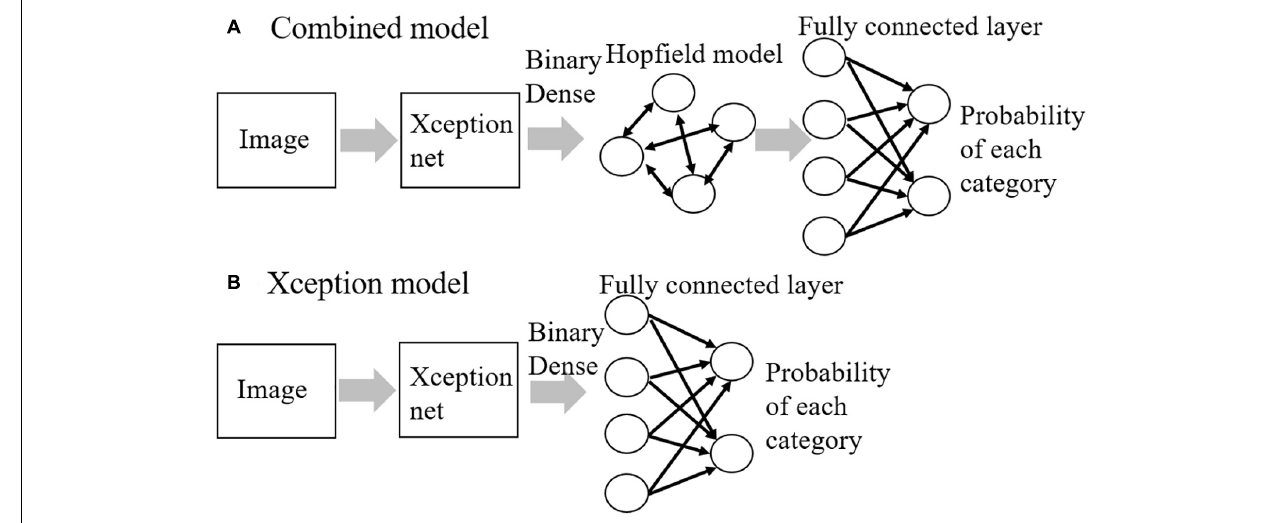
FIGURE 1 | The model structures for (A) combined model and (B) Xception model.